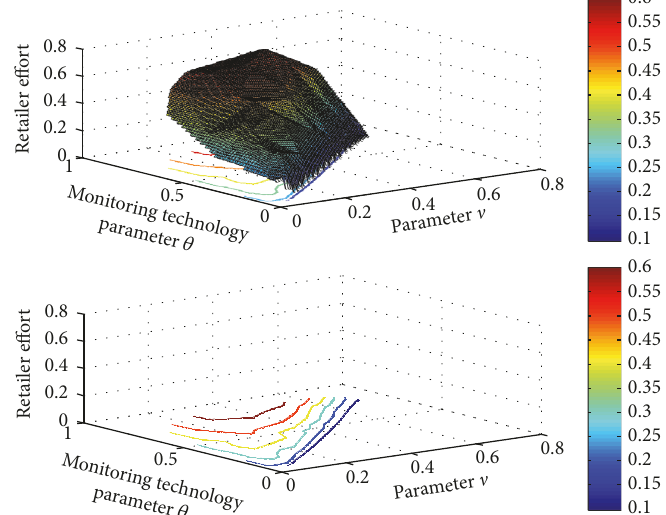
Figure 5: Relationship between the retailer’s effort and the technical parameters.